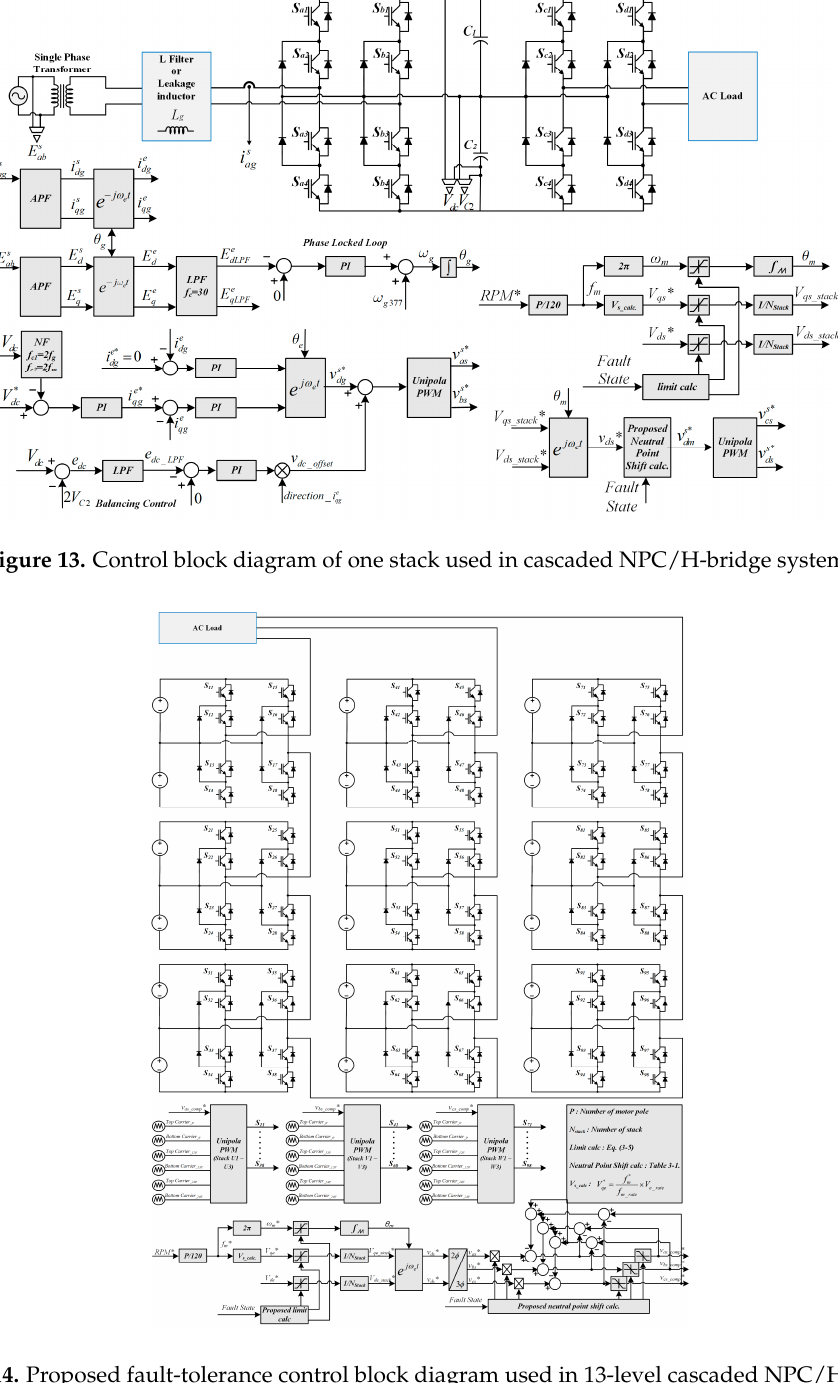
Figure 14. Proposed fault-tolerance control block diagram used in 13-level cascaded NPC/H-bridge inverter.